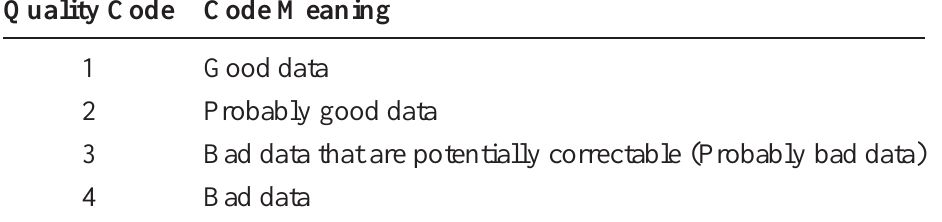
Table 1. The four quality states specified for the quality flag scheme of the Intergovernmental Oceanographic Commission (IOC). These four discrete states are used to represent the hidden quality state (node C in Figure 3) of the Bayesian network implementation. Each quality assessment involves performing an inference upon these quality states given the observed cause and effect variables of the network. The quality state of code 3 “bad data that is potentially correctable” was referred to as probably bad data in the